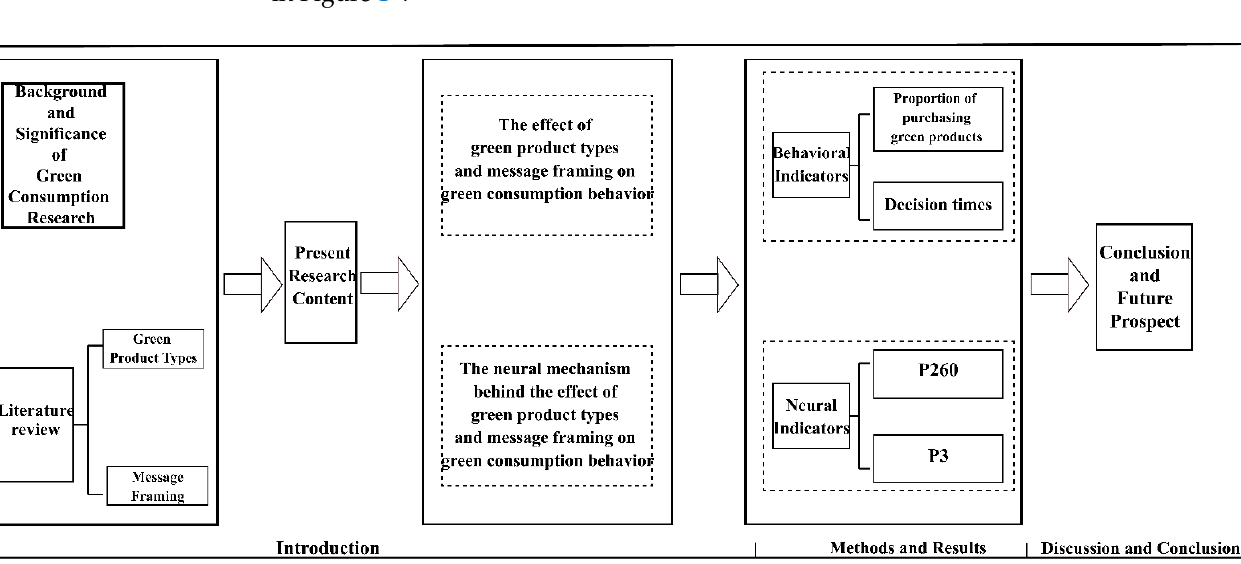
Figure 1. A technical roadmap of the